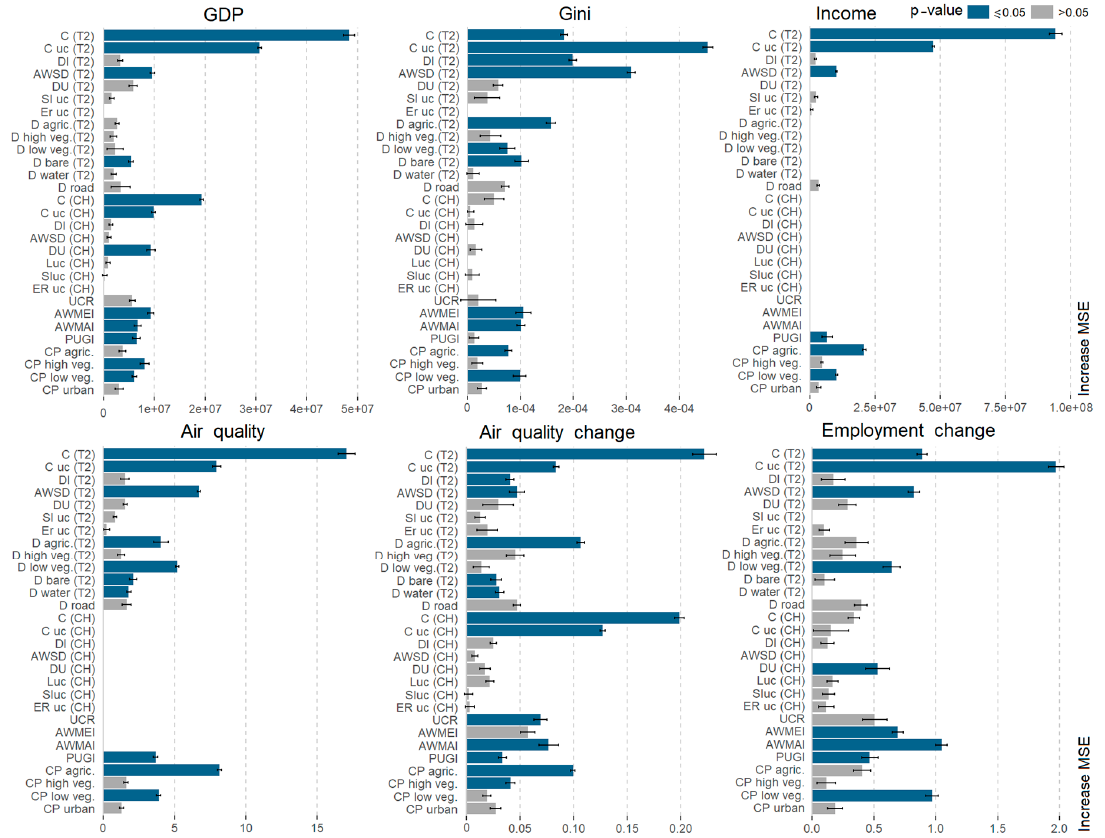
Figure 5. Spatio-temporal metrics’ importance for the different regression models. The importance is represented by the mean and the standard deviation of the increase in the MSE (the units and final MSE of the model can be found in Tables 2 and 3). Blue bars indicate statistically significant variables in the model. Where the bar is missing, the metric is not included in the model.